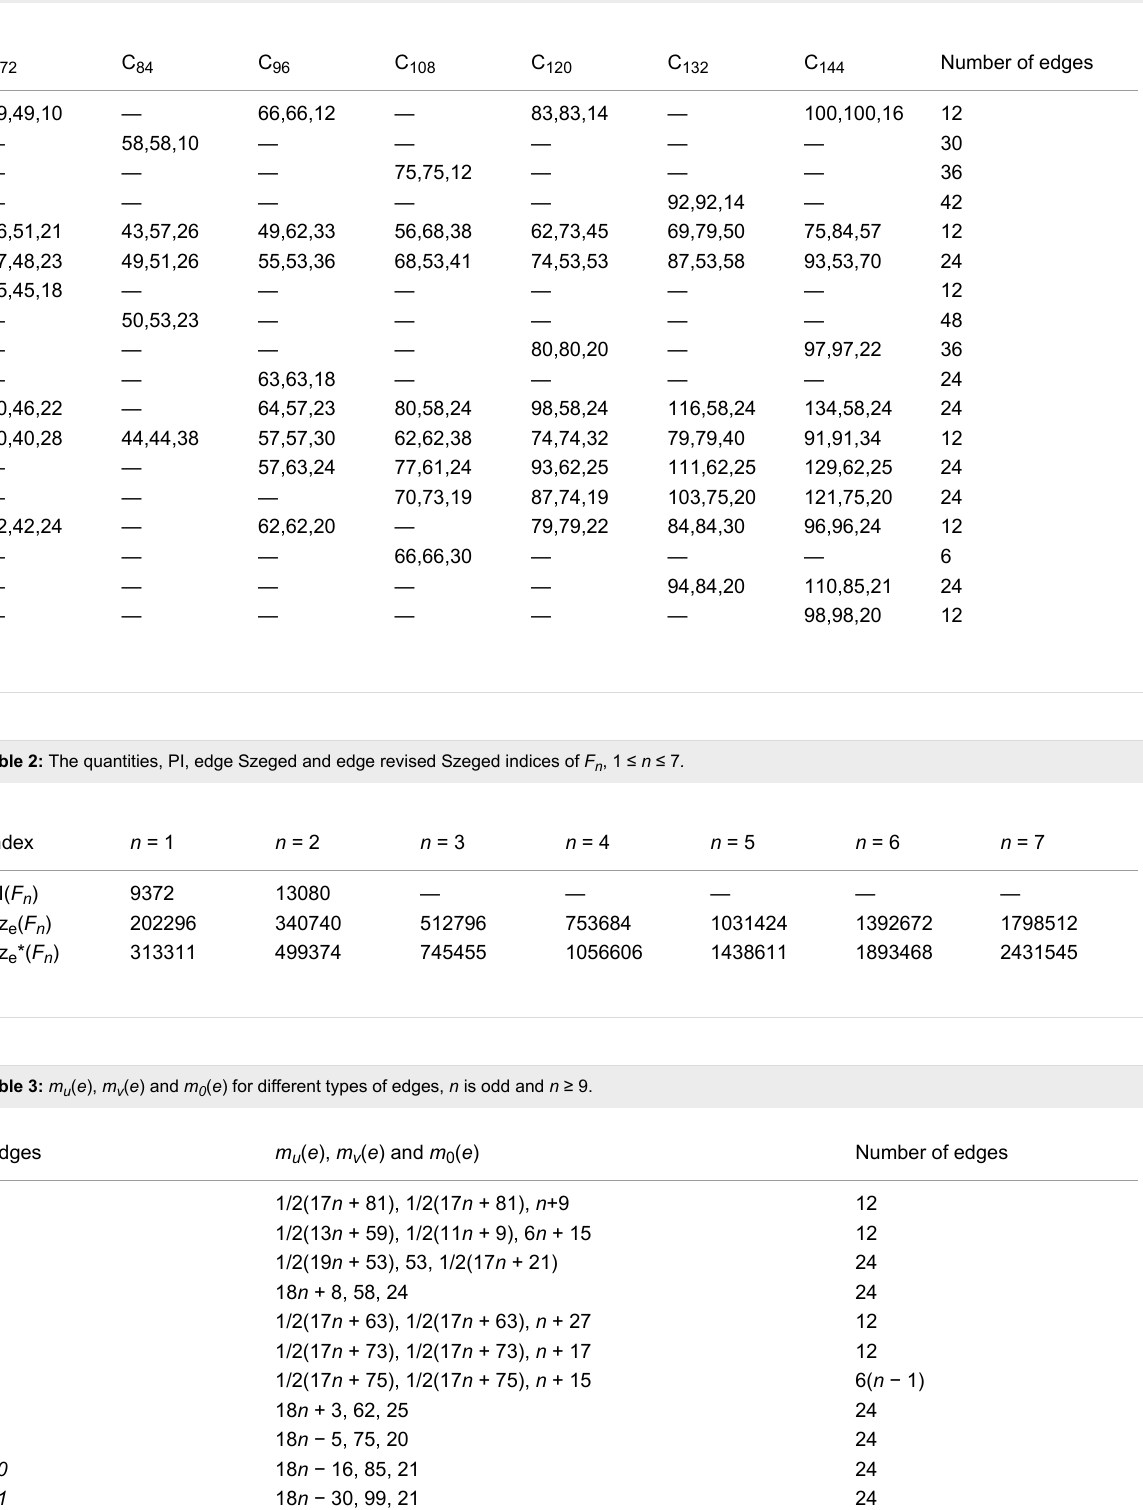
Table 1: The values of m u ( e ), m v ( e ) and m 0 ( e ) for different types of edges, when n ≤ 7.